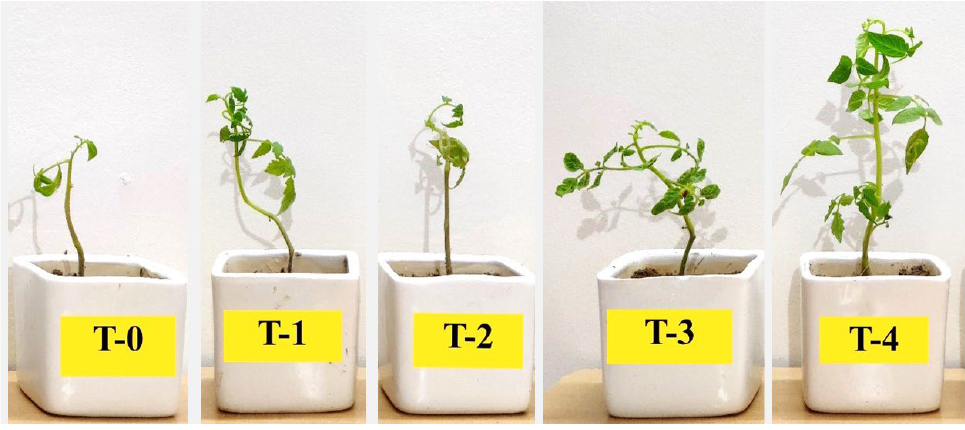
Figure 6. The visible effect of isolates inoculation on the shoot height of S. lycopersicum as compared to control.